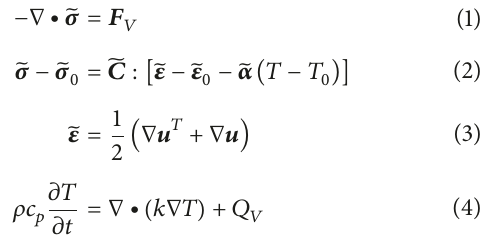
a graphite heater and the surrounding pipes called pressure tube (PT) and calandria tube (CT) [7]. As the gap